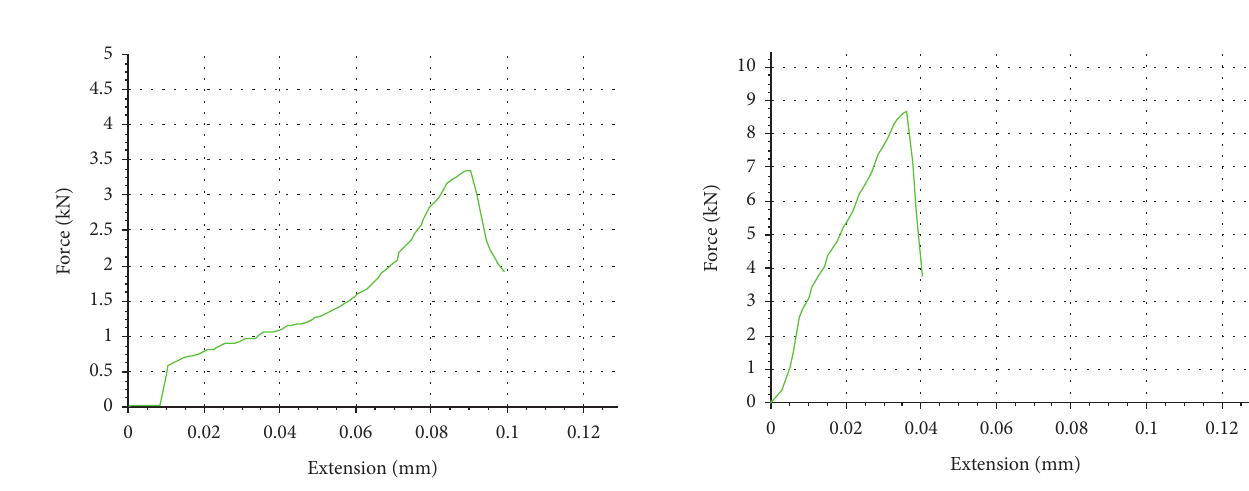
Figure 6: BBC-A. Figure 7: